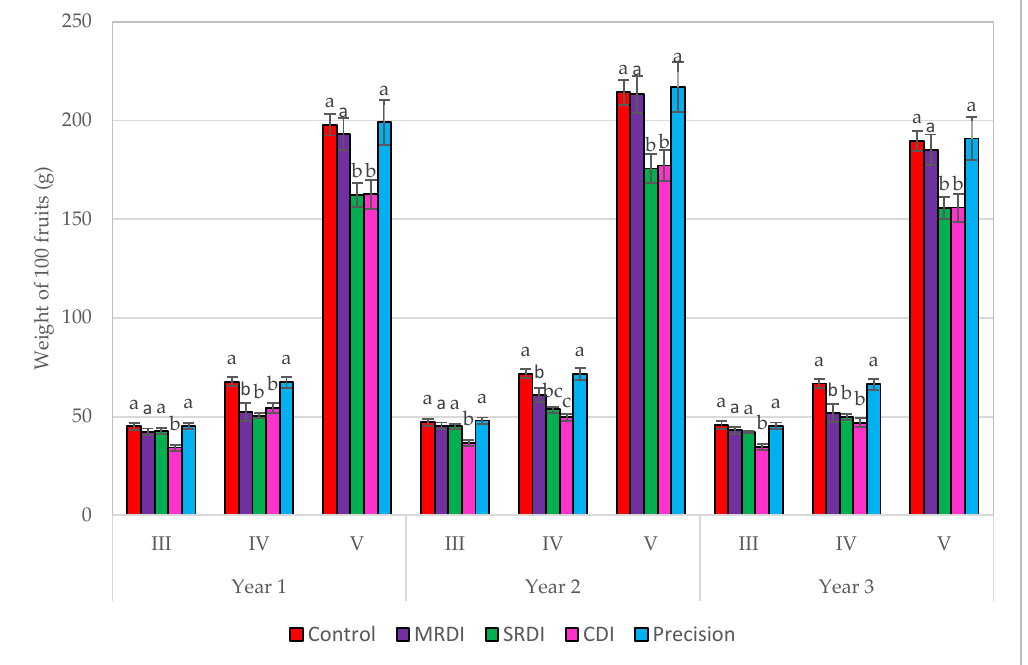
Figure 3. Evolution of 100 fruits’ mean weight and standard deviation (g) from the beginning of the summer vegetative stop (mid-July) (III) to the harvest (first of November) (V), over three tested years. (MRDI: moderate regulated deficit irrigation; SRDI: severe regulated deficit irrigation; CDI: continuous deficit irrigation). Different letters showed significant differences ( p ≤ 0.05) among treatments for the same year according to Duncan’s test.